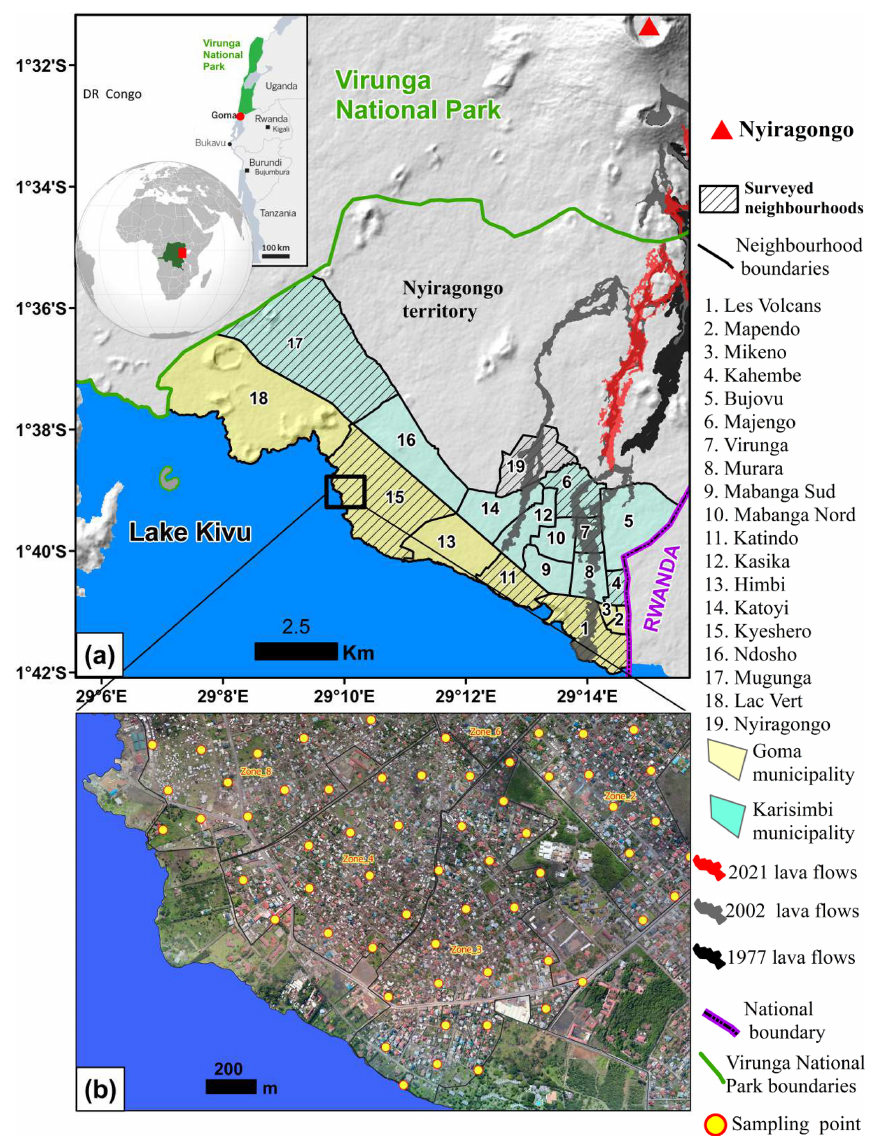
Figure 1. (a) The city of Goma and the surveyed neighbourhoods with a hill shade of SRTM 1 DEM (© NASA/NGA) updated with the 2016 topography of the Nyiragongo crater (Delhaye and Smets, 2021) and (b) an example of sampling points automatically distributed by defining a shortest distance allowed between two randomly placed points plotted on a 2017 very high resolution orthomosaic picture of Goma (Smets et al., 2018). The distance was determined according to the surface of the neighbourhoods, 40m for very wide neighbourhoods and 20m for narrower